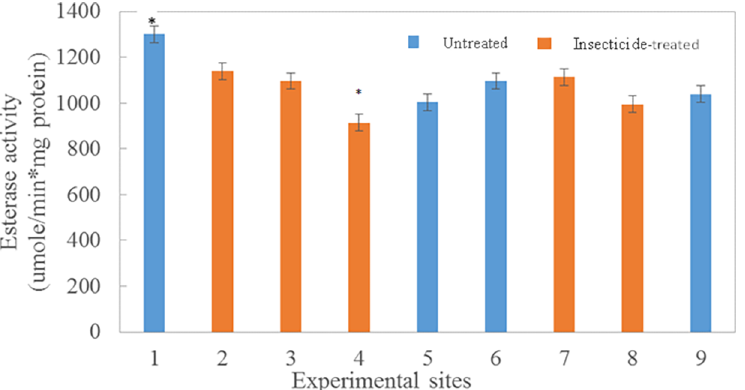
Fig 3. Esterase activity from bees collected during a seven week period from insecticide-treated (orange bars) or– untreated (blue bars) sites. Bars represent mean activities (μmole/min (cid:3) mg protein; ± SEM) based on triplicate assays made from 10 bees collected weekly at 3 colonies from each treated or untreated site. Asterisks signify mean values that are significantly different (P <